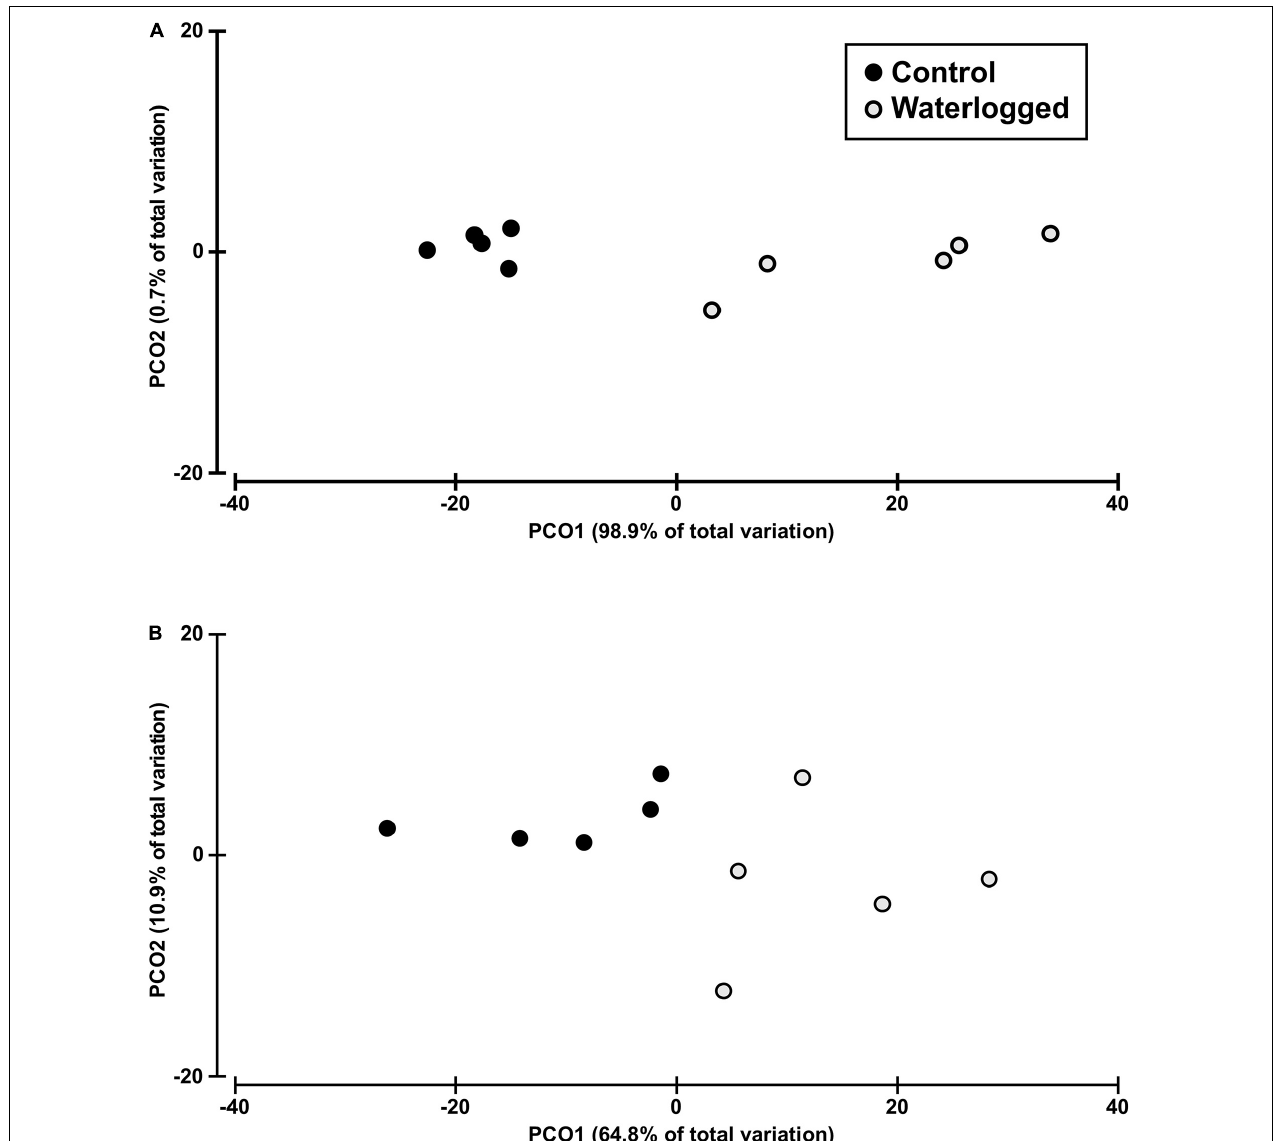
FIGURE 13 | Canonical analysis plot based on the Kautsky plot (A) , and thermography (B) in leaves of control plants (black circles) and waterlogged plants (gray circles) of Spartina patens after 30 days ( n = 5, different letters indicate significant differences at p <